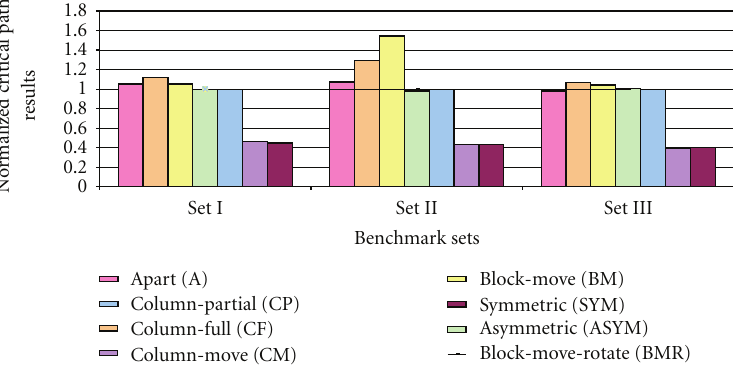
Figure 17: Generalized critical path results of mesh- and tree-based architectures.